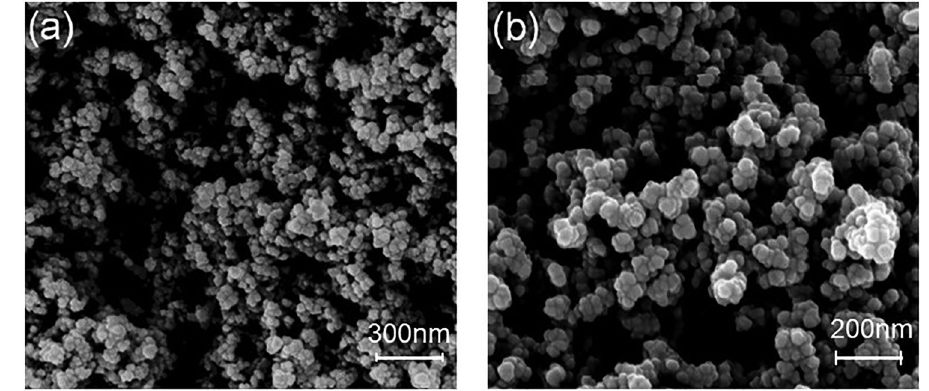
Figure 2: SEM of C/SiO 2 composite aerogel before ( a ) and after ( b ) heat treatment.